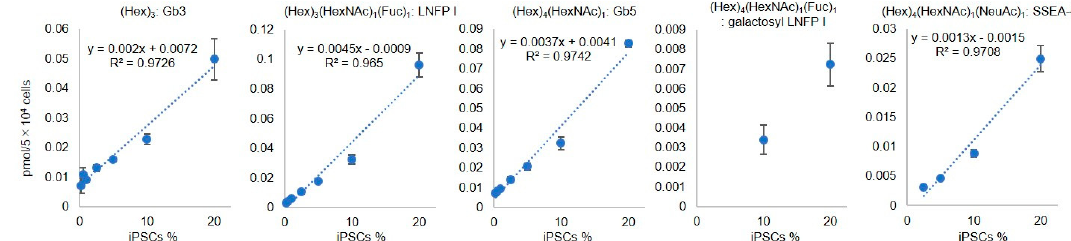
Figure 2. Linear dynamic ranges of the quantification of (Hex) 3 : Gb3, (Hex) 3 (HexNAc) 1 (Fuc) 1 : LNFP I, (Hex) 4 (HexNAc) 1 : Gb5, (Hex) 4 (HexNAc) 1 (Fuc) 1 : galactosyl LNFP I, and (Hex) 4 (HexNAc) 1 (NeuAc) 1 : SSEA-4 at various iPSC ratios (iPSC content = 20%, 10%, 5%, 2.5%, 1%, 0.5%, and 0.25%). Error bars indicate standard deviation (SD) for triplicate measurement.